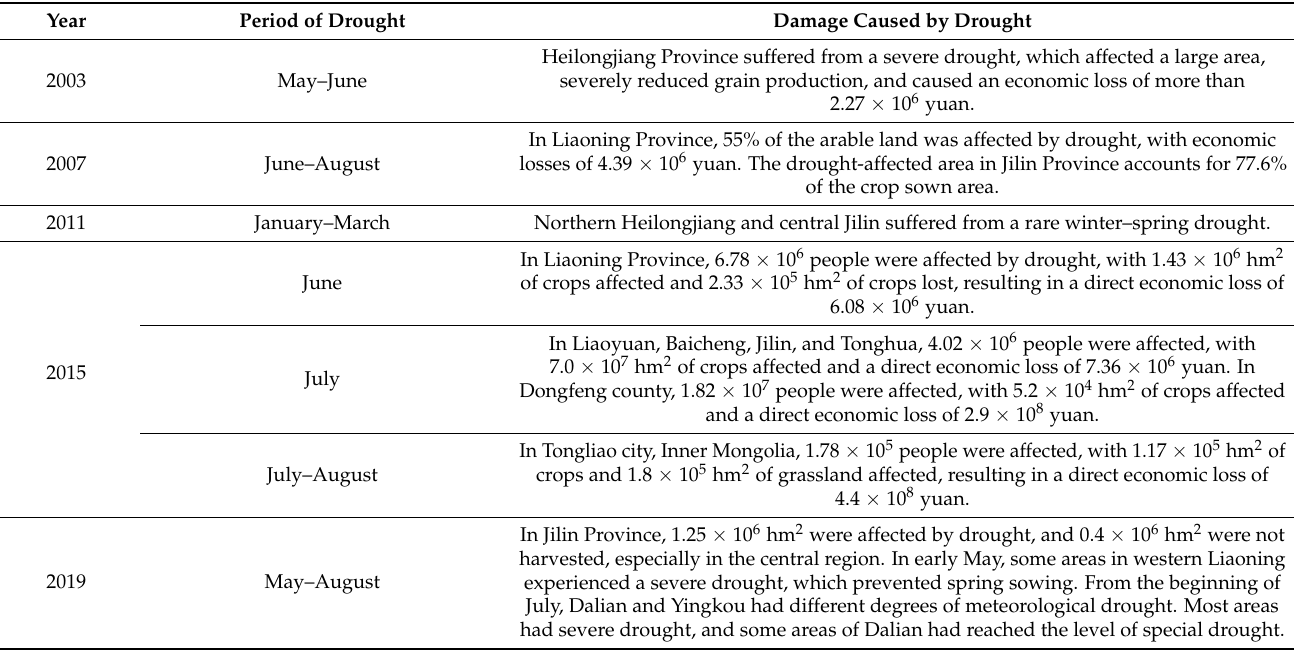
Table 1. Records of historical drought disasters in the Songliao Plain.